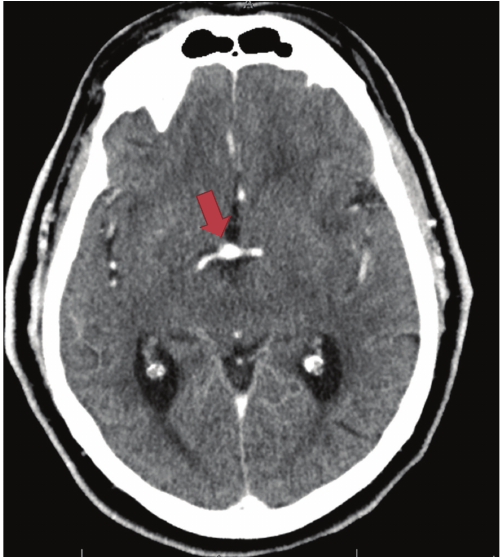
Figure 2: There is a second saccular-type aneurysm originating at the posterior cerebral artery segment of the left internal carotid artery. The width of the aneurysm fundus measures 8mm; the aneurysm neck measures 2.7mms; the neck-to-dome distance mea- sures 8 mm. The long axis of the aneurysm projects inferomedially.